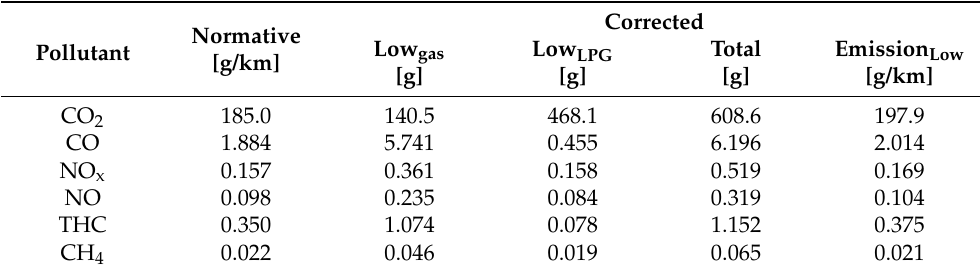
Table A4. Comparison of exhaust emissions calculated by the normative and corrected method for the Low phase of the WLTC cycle—measurement No. 4.